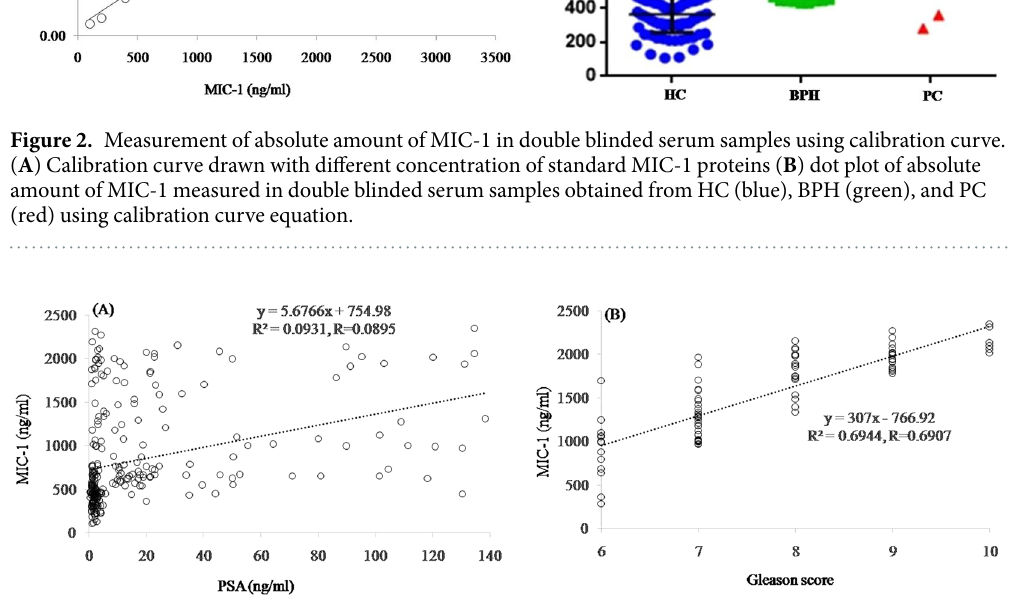
Figure 3. Regression analysis between ( A ) PSA versus MIC-1 and ( B ) MIC-1 verses Gleason score. The correlation is extremely significant ( p < 0.001) between PSA versus MIC-1 and MIC-1 verses Gleason